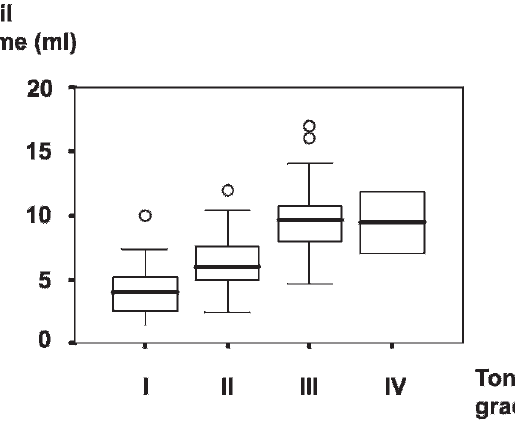
Figure 2 - Box plot of tonsil volume versus tonsil grade (I , II , III, p= 0.005). Open circles indicate